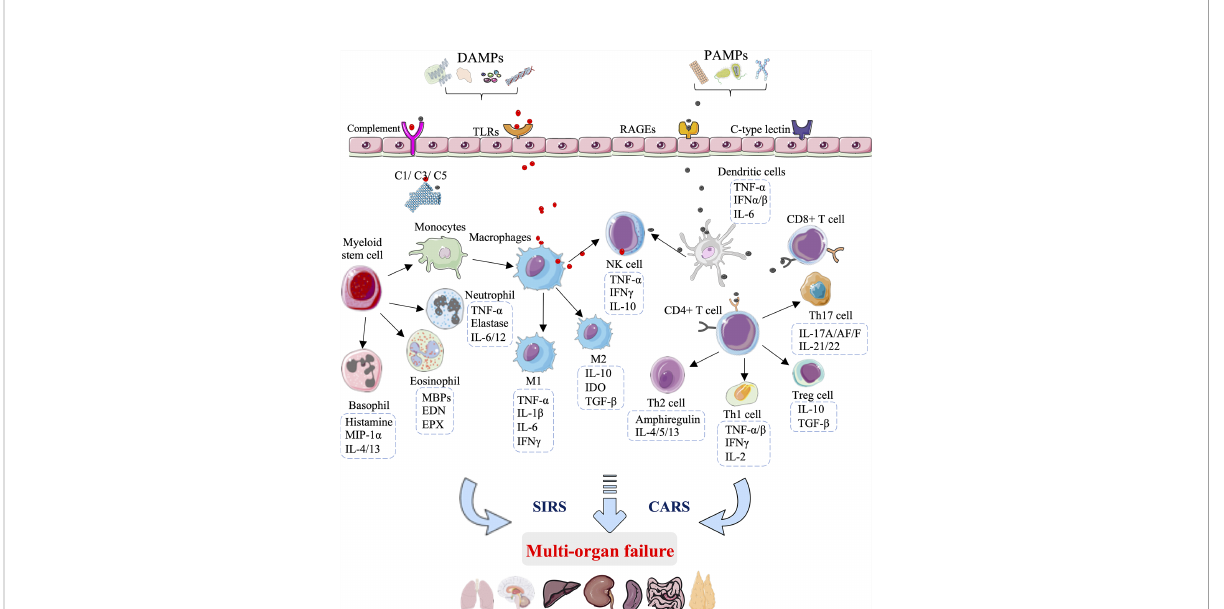
FIGURE 1 Innate immunity-mediated pathomechanisms in multi-organ failure development after hemorrhagic shock. During the development of hemorrhagic shock, the innate immunity rapid response to damage-associated molecular patterns (DAMPs) and pathogen-associated molecular patterns (PAMPs) is mediated through pattern recognition receptors, including toll-like receptors (TLRs), receptors of advanced glycation end products (RAGEs), C-type lectin receptors, and complement receptors. The early and exaggerated activation of innate immunity results in excessive activation of complement factors(C1/C3/C5) and innate immune cells, comprising macrophages, DC cells, T cells, natural killer (NK) cells, eosinophils, basophils, and neutrophils. The activation of innate immune cells leads to the secretion of cytokines and chemokines, which exaggerates in fl ammation and subsequent immunosuppression, causing systemic immune response syndrome (SIRS) and a counterbalancing anti-in fl ammatory response syndrome (CARS), ultimately leading to multi-organ